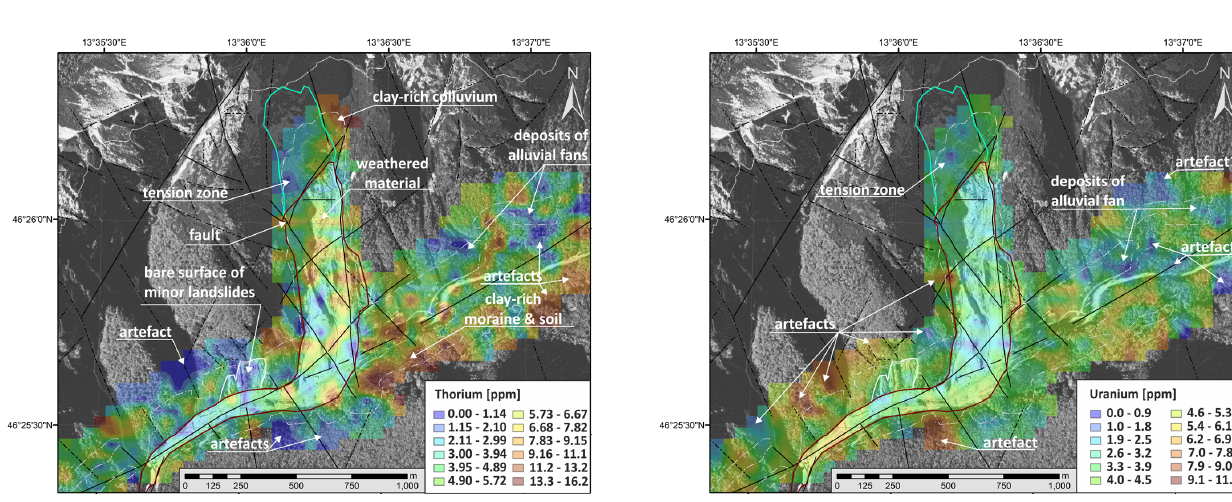
Fig. 7. Gamma ray survey: a map of Thorium combined with the fault and joint pattern (black full and dot-and-dashed lines), area of reliable data (light grey dot-and-dashed line) and the geological interpretation; the units are parts per million [ppm] (Source of data: Geological Survey of Austria and Google Earth).